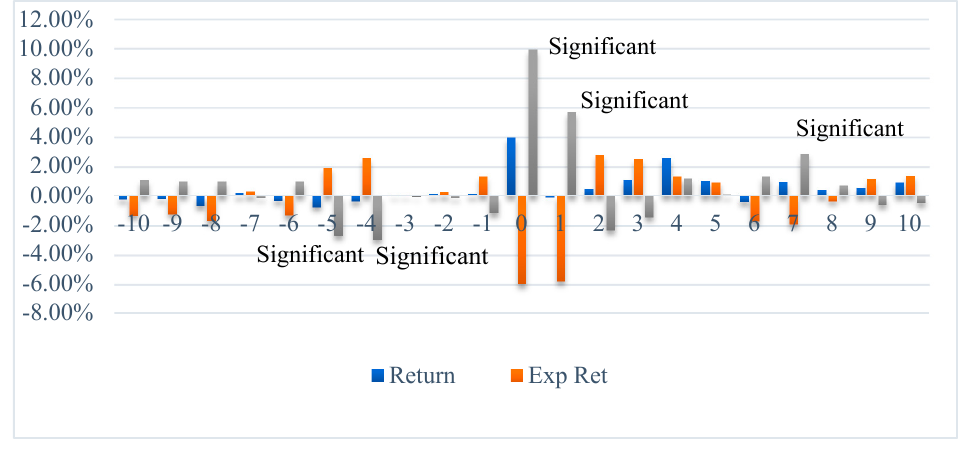
Figure 1. World Equity ETF.